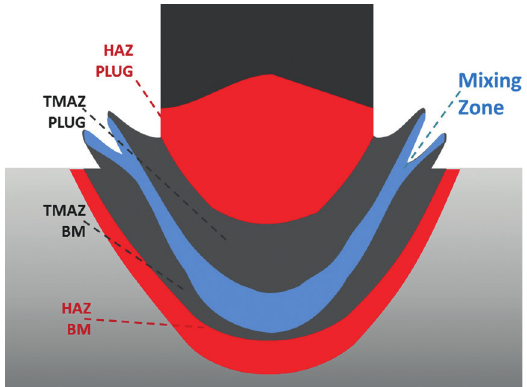
Figure 9: Mixing zone (MZ) shows Widmanstätten (WA), grain boundary allotriomorphs (GBA) and transgranular austenite particles (IGA).